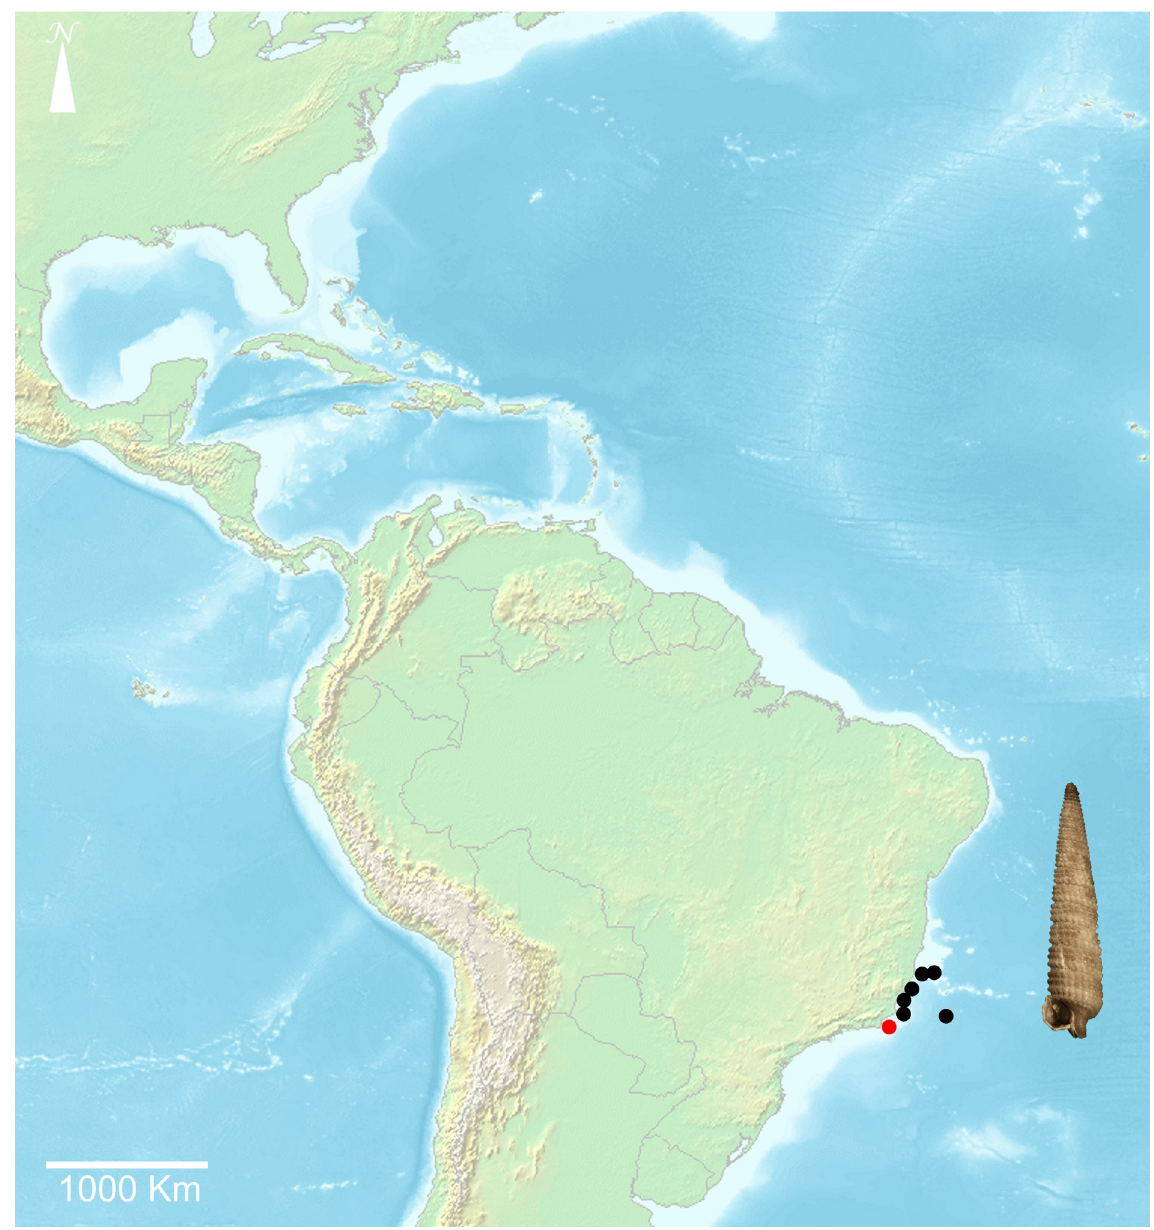
Fig. 42. Distribution map of “ Inella ” maculata Fernandes & Pimenta, 2019; red circle = type